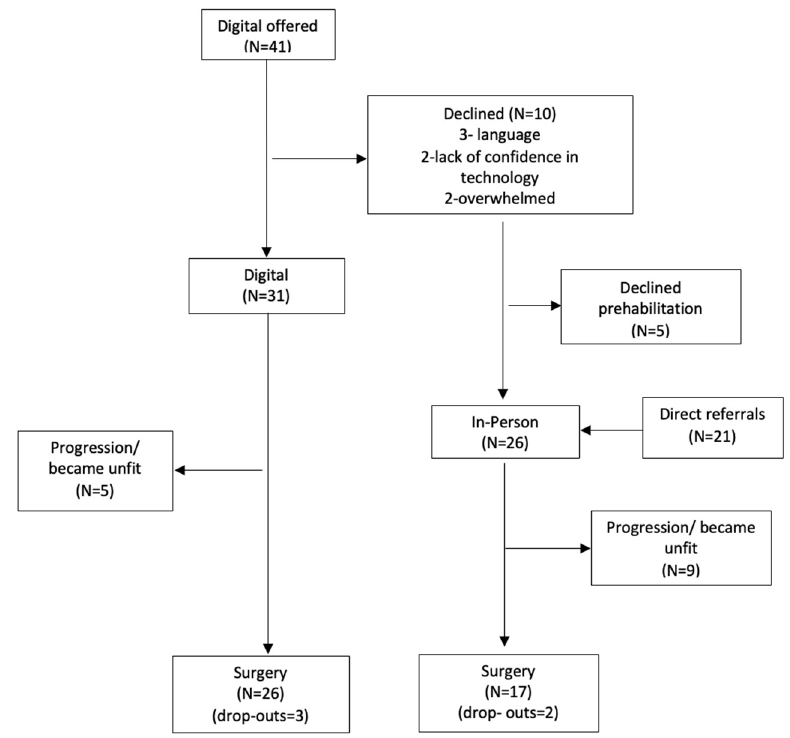
Figure 1. Flow chart of patients recruited.